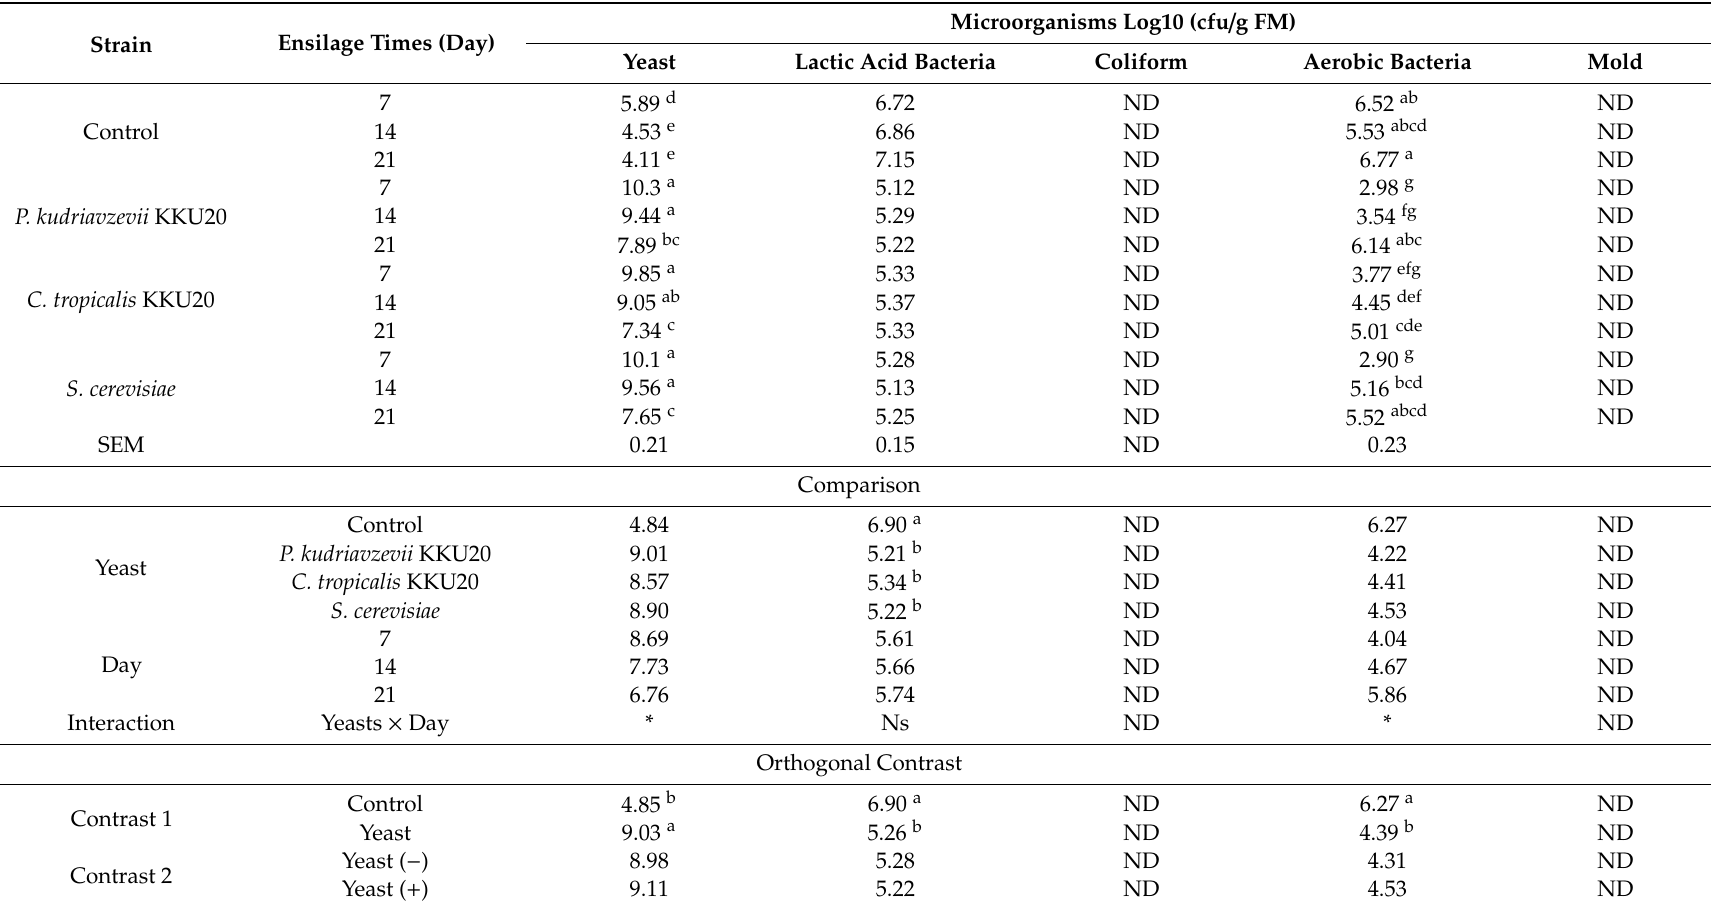
Table 2. Microbiological analysis of rice straw fermented with Crabtree-positive and -negative yeasts.